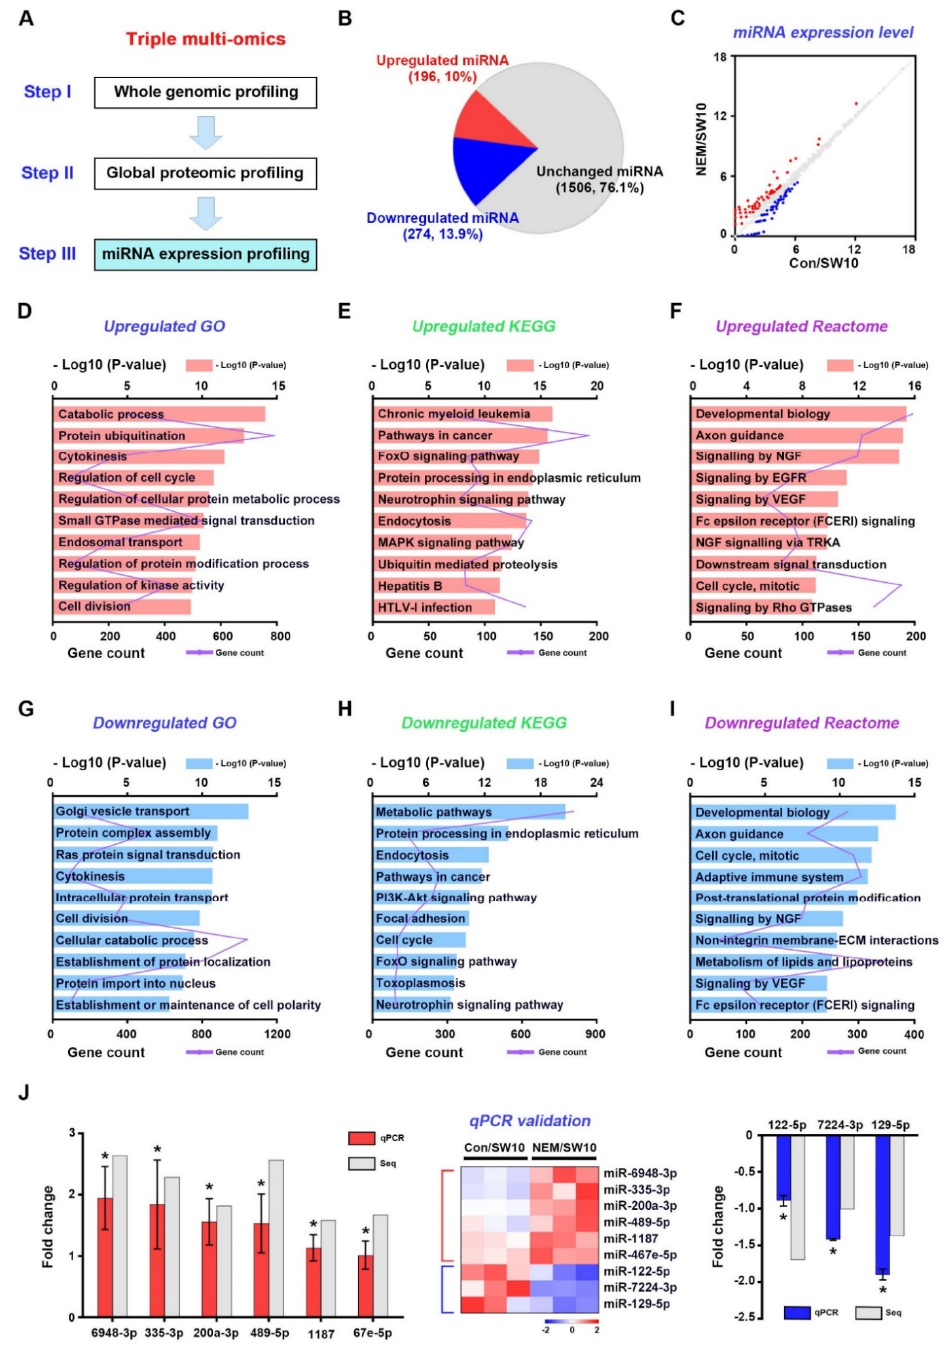
Figure 5. miRNA expression profiling with NEM as an inhibitor for hydrogen sulfide pathway. ( A ) The third stage of a three-stage framework for integrating triple multi-omics data. ( B ) A pie chart displays 10% upregulated and 13.9% downregulated miRNAs in the total number of miRNAs (1976) between DMSO- and NEM-treated SW10 cells. ( C ) A scatter plot of the comparison of miRNA expression between DMSO- and NEM-treated SW10 cells. Upregulated and downregulated miRNAs are indicated by red dots in the upper region and blue dots in the lower region, respectively. Using upregulated miRNAs, GO terms ( D ), KEGG pathways ( E ), and Reactome analysis ( F ) are shown. Using downregulated miRNAs, GO terms ( G ), KEGG pathways ( H ), and Reactome analysis ( I ) are shown. ( J ) qPCR validation of top 5 upregulated and downregulated miRNAs. The log2 FC was shown in both RNA-sequencing (Seq) and the validation. Heatmap shows the relative expression levels of miRNAs. Comparisons were performed using a Student’s t -test. * p <